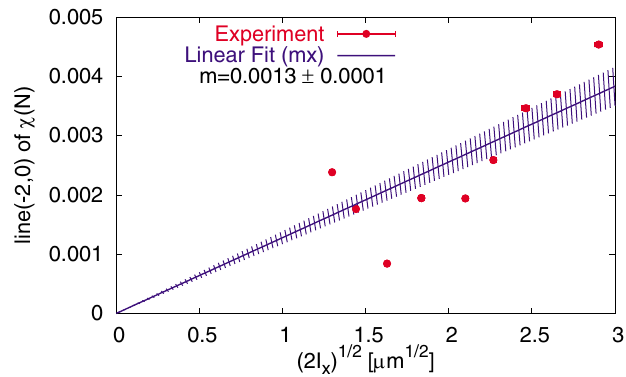
FIG. 2. (Color) Amplitude of the spectral line with frequency (cid:5) 2 (cid:8) [line (cid:1)(cid:5) 2 ; 0 (cid:2) ] from the Fourier spectrum of (cid:25) (cid:1) N (cid:2) versus p x (cid:1)(cid:1)(cid:1)(cid:1)(cid:1)(cid:1)(cid:1) 2 I . x